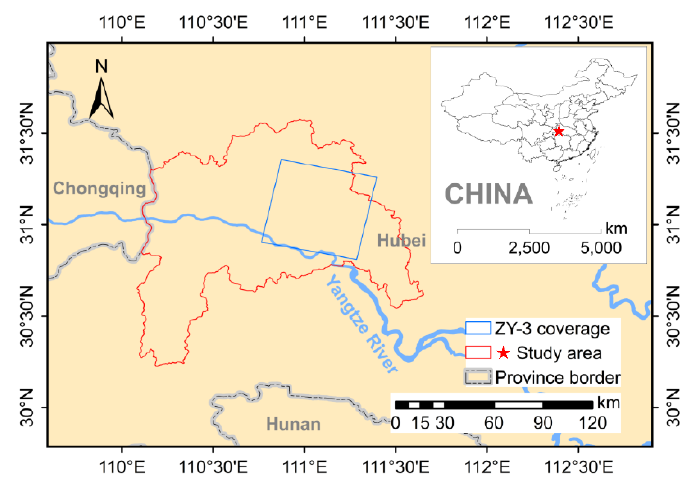
Figure 1. Location of the study area.